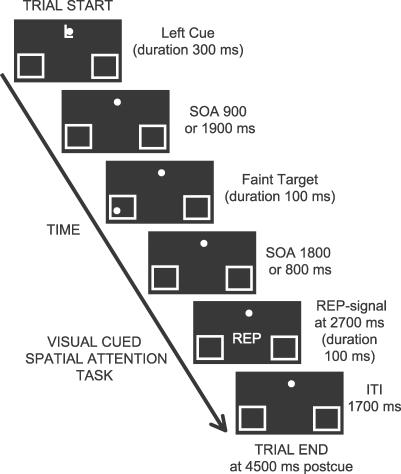
Example of an Attend-Left Cue–Plus–Target TrialA centrally presented left cue (letter L) instructed the participant to covertly attend to the lower left visual field box to detect an upcoming faint dot target that might be presented there. A target could appear either early or late (50% probability) following the cue and at the valid location only. An end-of-trial signal (the letters REP) presented at 2,700 ms post-cue signaled the participant to press a button to report if they had seen a target. Other trial types included attend-right cue–plus–target, attend-left cue–only (no target), attend-right cue–only (no target), interpret-cue (also no target), and NoStim trials (no cue nor target).SOA, stimulus onset asynchrony; ITI, interstimulus interval.